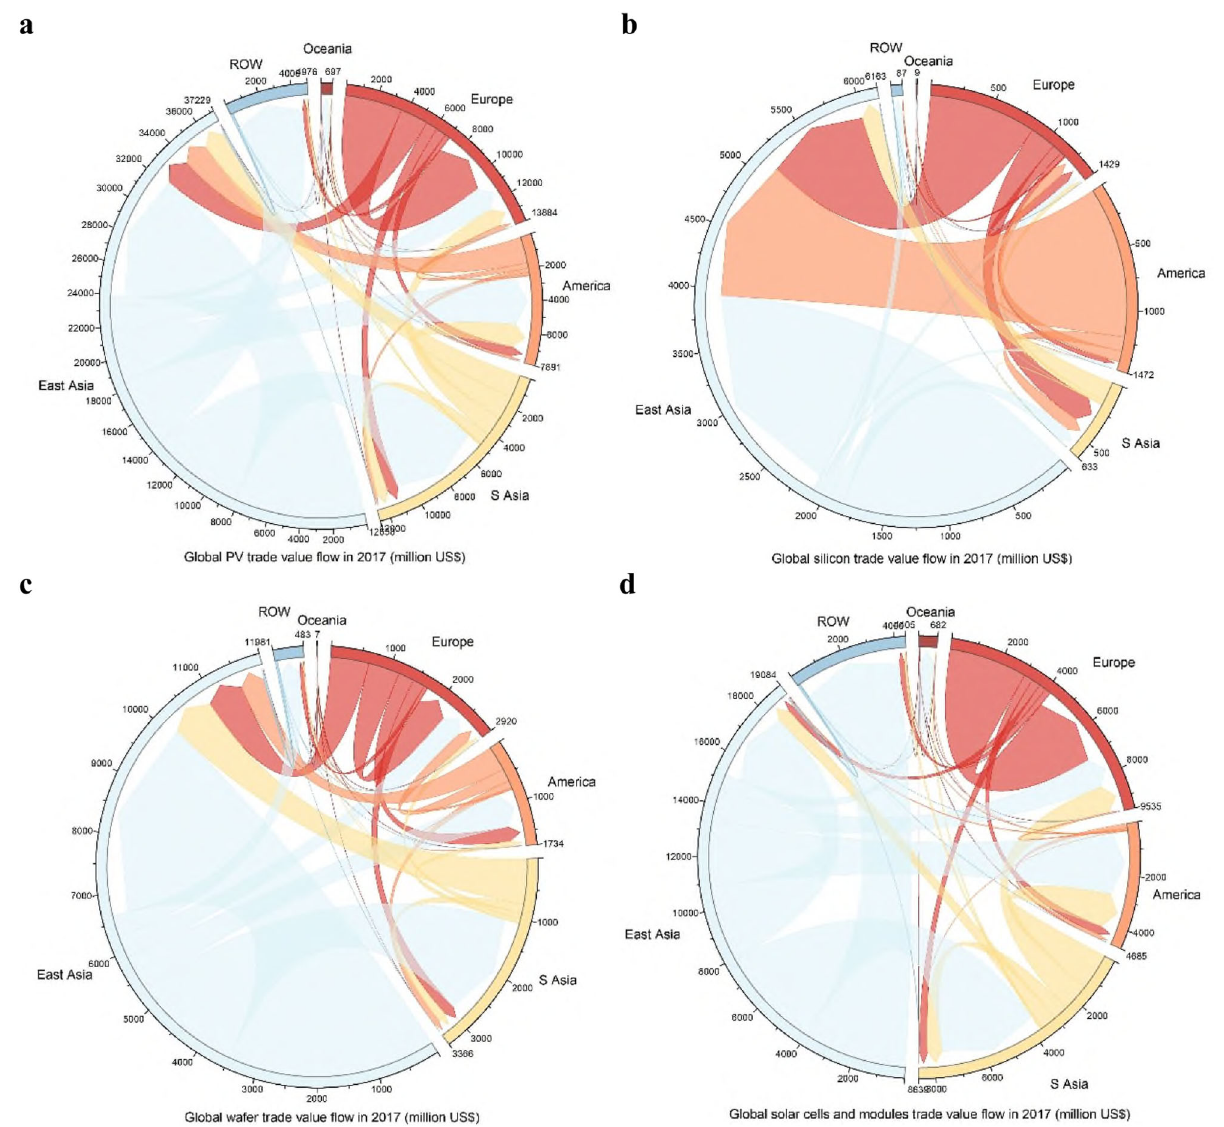
Fig. 1 Global solar photovoltaic (PV) product trade fl ow. Chord graphs present global PV product trade fl ows in 2017, including total trade value fl ows and three categories of PV product trade fl ows. S Asia is the abbreviation for Southeast Asia. ROW is the abbreviation for the rest of the world. Light blue ribbons represent trade fl ows from East Asia and ROW, and yellow, orange, red and dark red ones are trade fl ows from Southeast Asia, America, Europe and Oceania, respectively. a This fi gure shows global total PV trade fl ows. East Asia is the largest PV product exporter and importer region, and Southeast Asia is the second largest importer region. The largest interregional fl ow is from East Asia to Southeast Asia. b – d Describe global trade value fl ows of silicon, wafers, and solar cells and modules, respectively. East Asia leads in all PV product trade. Europe and the Americas tend to produce and export silicon to and import solar cells and modules from Asia. Southeast Asia acts as an important exporter of silicon wafers and solar cells and modules and have close trade links with other regions (see Data sheet 3 – 5 in Source data for more details). This study converts all currencies to US$ fi rst and then converts them to 2010 US$ for